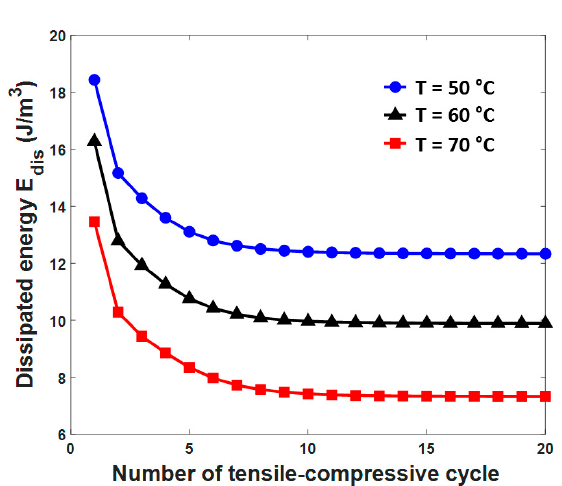
Figure 7. Variations in the dissipated energy dis E during tensile-compressive cycling under different temperatures, i.e., T = 50 ° C, T = 60 ° C, and T = 70 ° C.